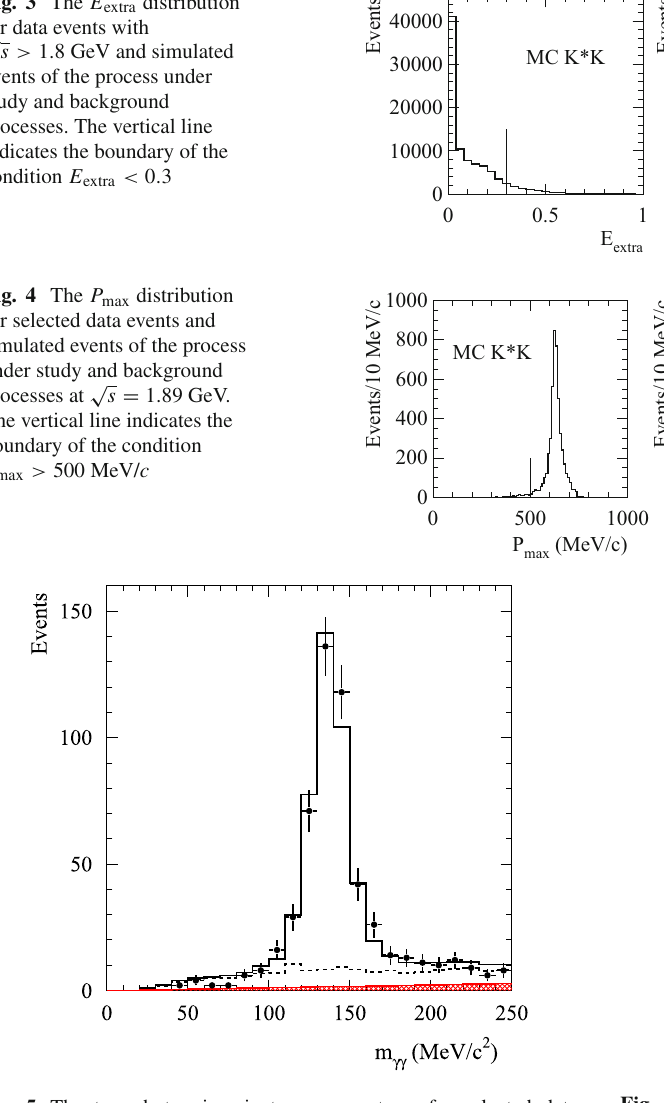
Fig. 5 The two-photon invariant mass spectrum for selected data √ s = 1 . 5–1.72 GeV (points with errors). The solid his- events with togram is the result of the fit to the data spectrum with the sum of the signal and background distributions. The dashed histogram represents the fitted background. The hatched histogram shows the part of the background described by the linear function